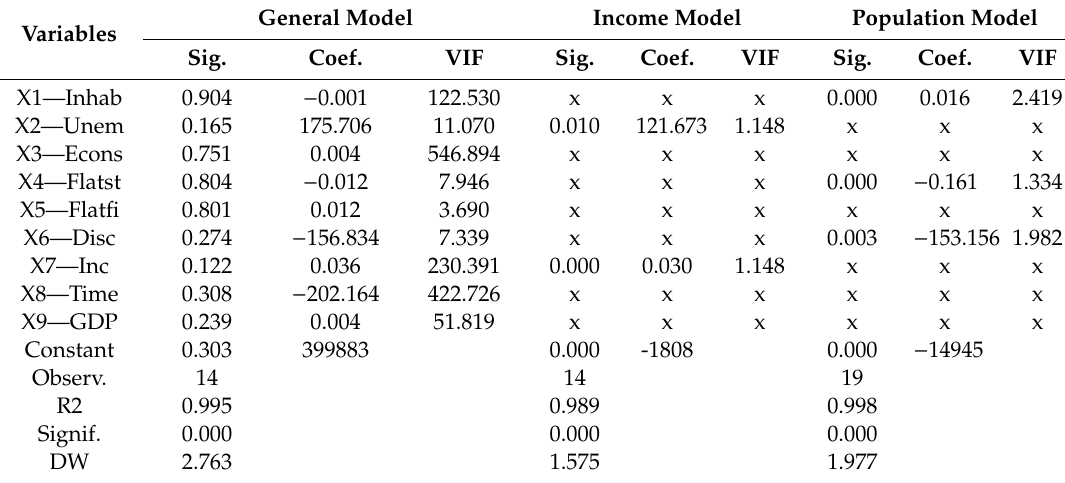
Table 3. Regression analysis for